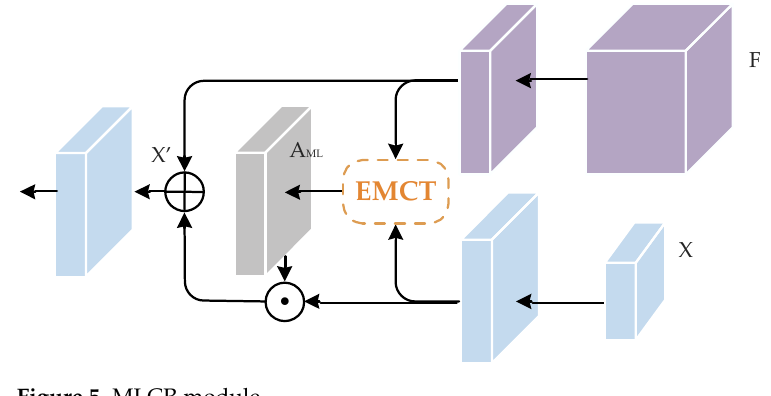
Figure 5. MLCR module.